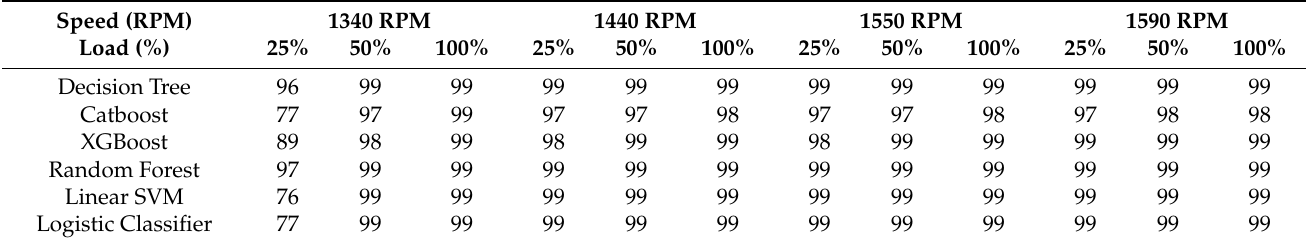
Table 5. Validation accuracy of using only I qr and I qrerr in different operating conditions.